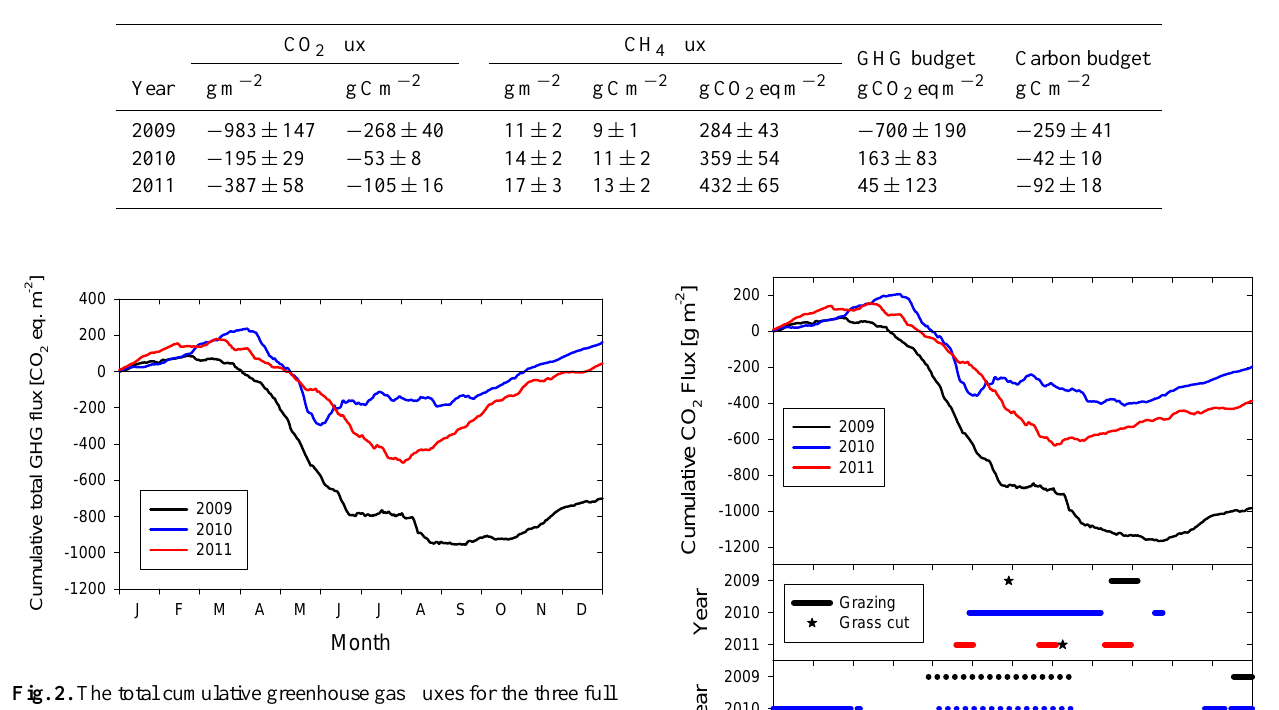
Table 2. Annual atmospheric greenhouse gas budget for the 3 full years of measurements. Upward fluxes are defined as positive.